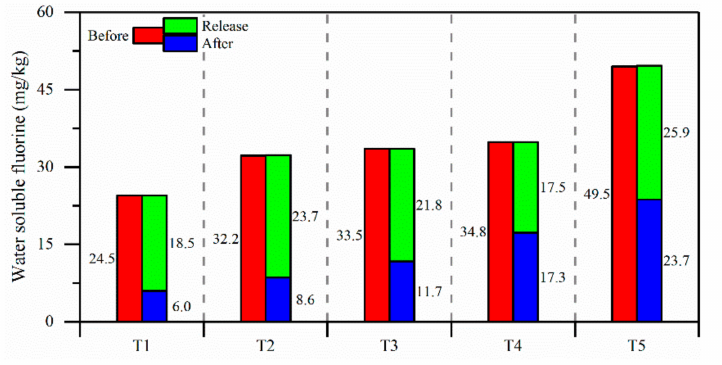
Figure 12. Change of water-soluble fluoride of soils before and after a soil column leaching